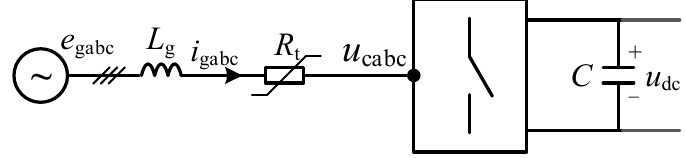
Figure 5. Schematic of VSC system with ideal switch.